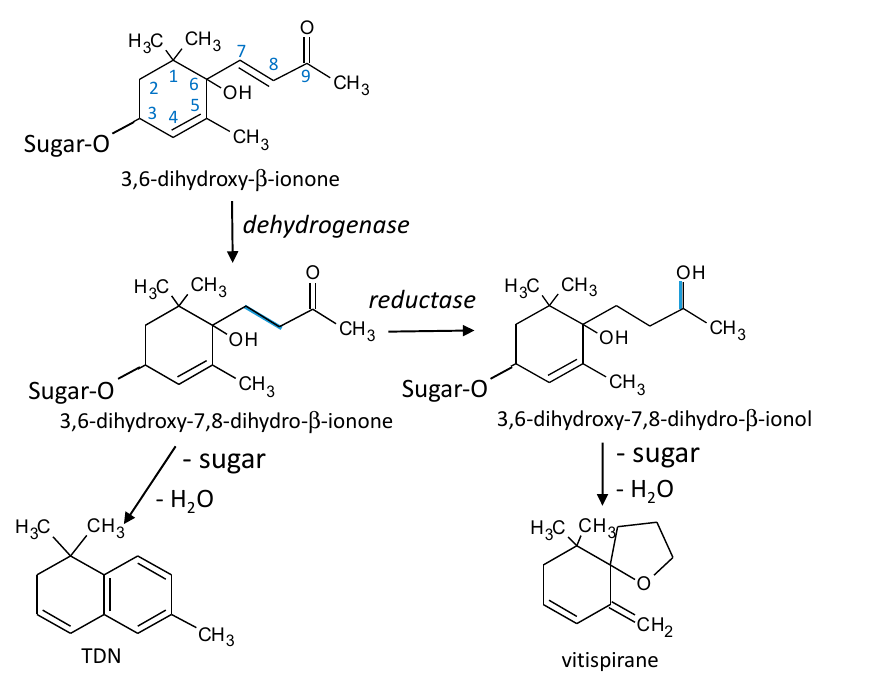
Figure 10. TDN and vitispirane formation from the glycosidic precursors: the formation of TDN and vitispirane from a common glycosidic precursor via enzymatic hydrolysis.